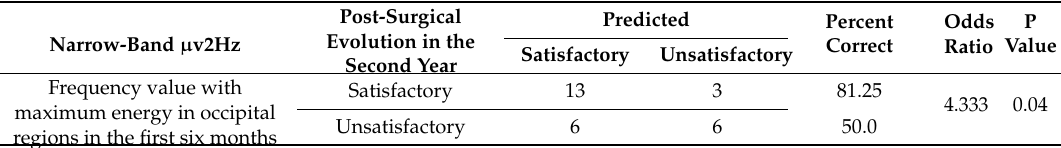
Table 3. Predictive analysis of frequency value with maximum energy in occipital regions in the first six months after surgery for two years seizure recurrence in patients with pharmacoresistant temporal lobe